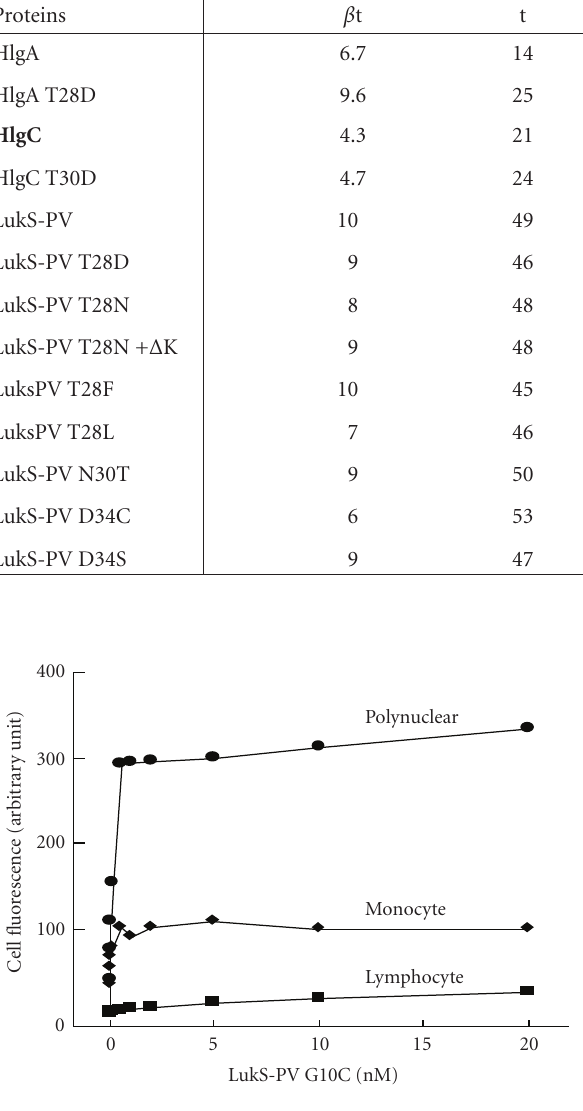
Figure 4: Determination by flow cytometry of LukS-PV G10C fluorescein-labelled association constant ( λ ex = 488nm, λ em = 5nm) with the human monocytes, polynuclears, and lymphocytes (2 × 10 5 cell/mL). Polynuclear: K D = 0 . 13nM; monocyte: K D = 0 . 04. The LukS-PV Concentration is in